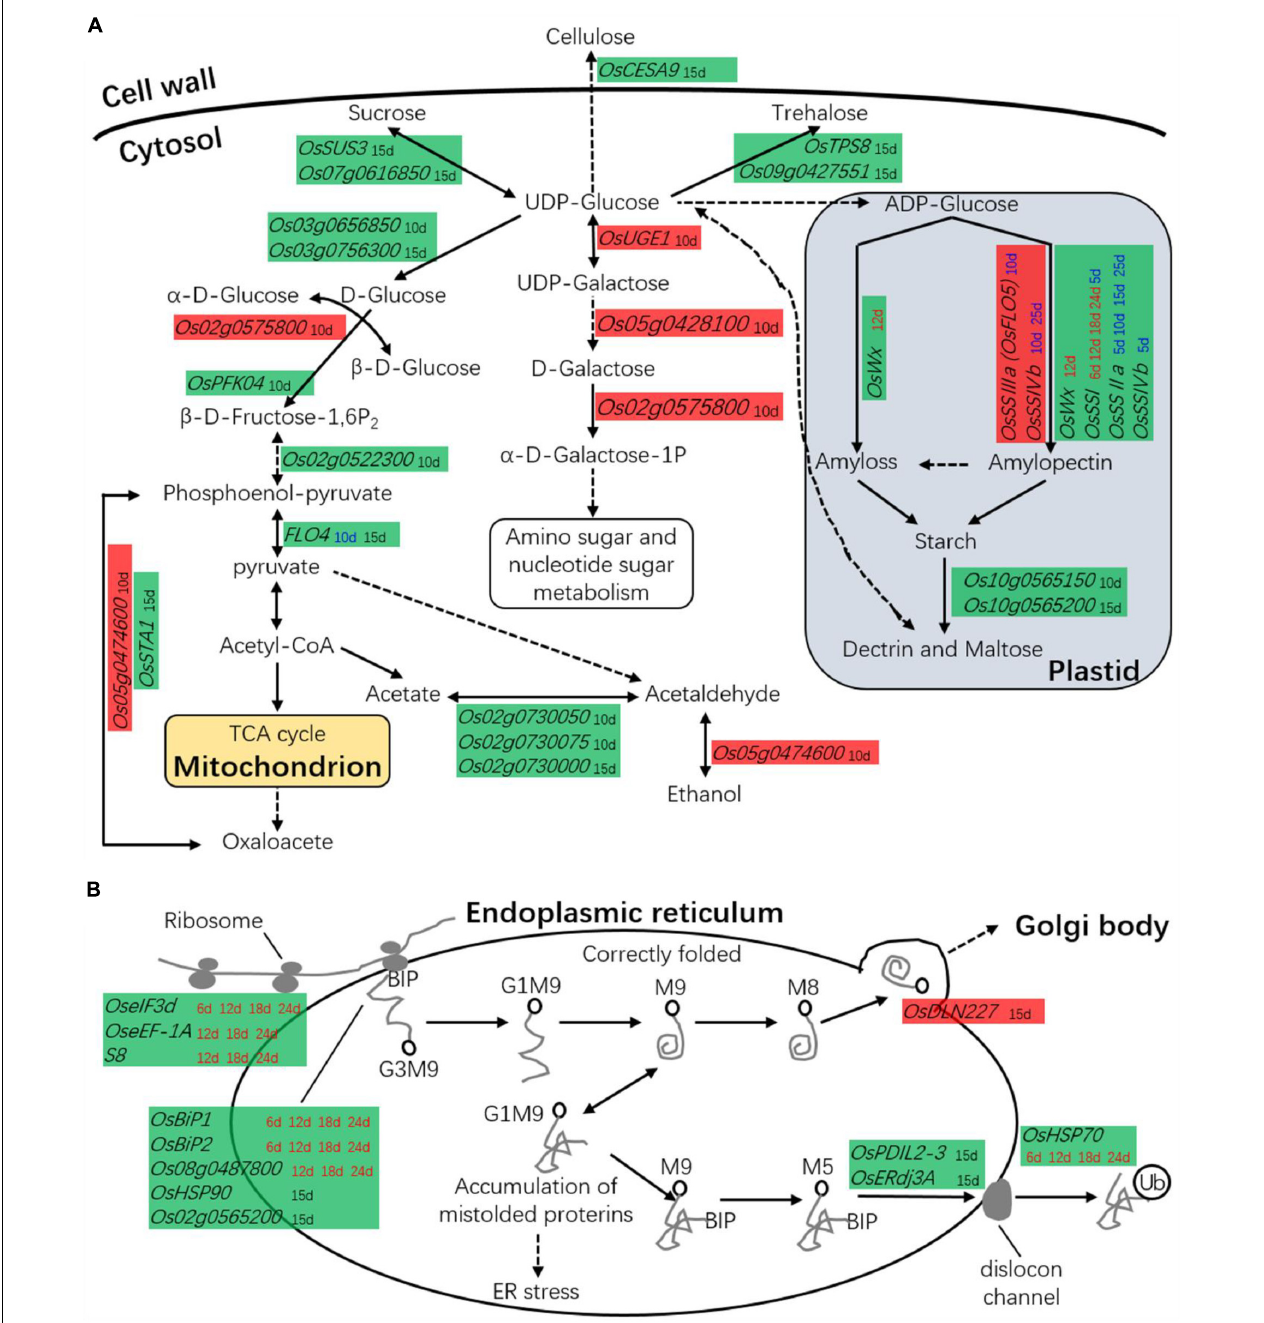
FIGURE 10 | The DEGs in carbon or protein metabolism. (A) DEGs are associated with carbohydrate metabolism. (B) DEGs are associated with protein metabolism. Red background box, the gene was upregulated in low-chalkiness lines; Green background box, the gene was downregulated in low-chalkiness lines; The time spots in different colored letters indicate DEGs from different sources; Black font, the DEGs from transcriptomic analysis; Red font, the DEGs from proteomics analysis; Blue font, the DEGs from time-course analysis by qRT-PCR. Solid lines represent one-step reactions, dotted lines represent multistep reactions, and arrows denote the reaction